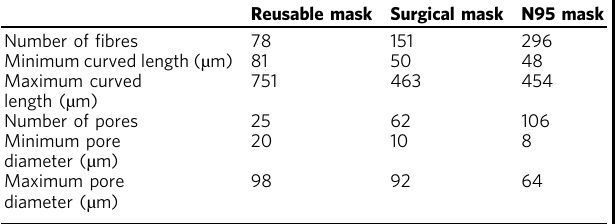
Their average values are plotted in Supplementary Fig.